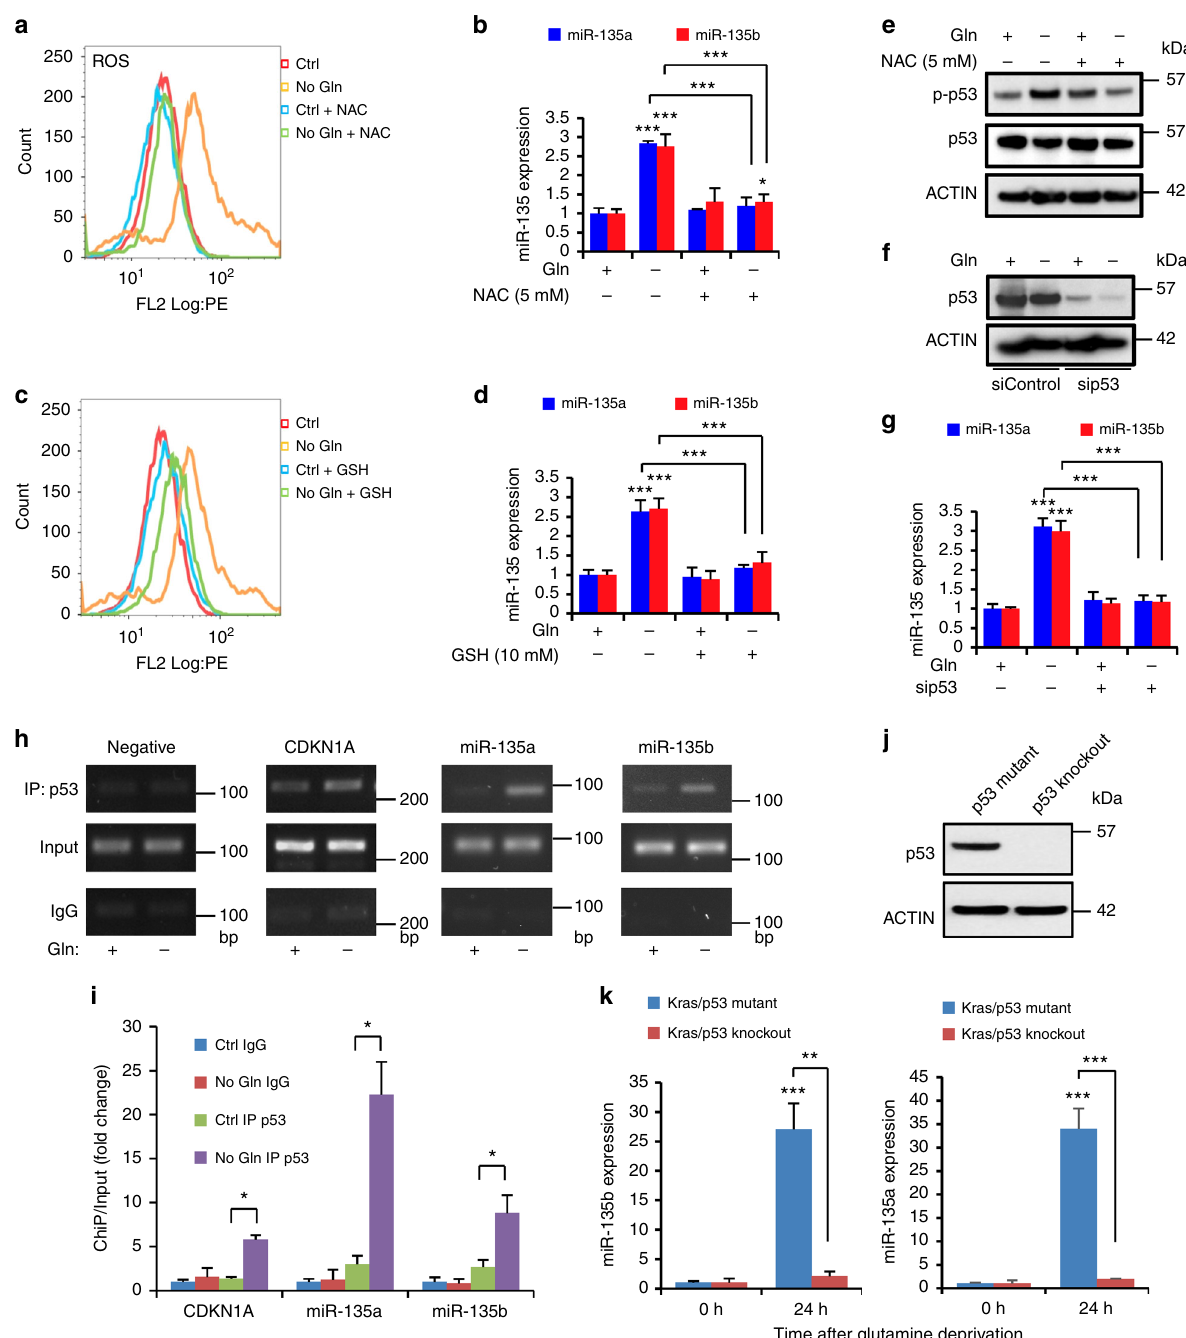
Fig. 2 miR-135 is induced by ROS-activated mutant p53. a , c MIA PaCa-2 cells were cultured in complete medium or glutamine-free medium supplemented with 5mM NAC or 10mM GSH for 24h. Then cells were stained with dihydroethidium and analyzed by fl ow cytometry or collected to assess relative miR-135a and miR-135b expression by qPCR ( b , d ). Each value represents the mean±SD in three independent experiments. * p <0.05, *** p <0.001, Student ’ s t test. e MIA PaCa-2 cells were cultured in complete medium or glutamine-free medium supplemented with 5mM NAC. Phospho-p53 (S15), total p53 and actin were assessed by western blotting. f p53 was knocked down by siRNA in MIA PaCa-2 cells. p53 protein was assessed by western blotting. g p53 knockdown and control MIA PaCa-2 cells were cultured in complete medium or glutamine-free medium for 24h. miR-135a and miR-135b expression were assessed by qPCR. Each value represents the mean±SD in fi ve independent experiments. *** p <0.001, Student ’ s t test. h Chromatin immunoprecipitation analysis was performed to determine p53 binding to the promoters of CDKN1A , miR-135a and miR-135b in response to glutamine deprivation. The binding was assessed by DNA gel. i The fold change of the p53 binding to the promoters of CDKN1A , miR-135a and miR-135b in response to glutamine deprivation were analyzed by qPCR. Each value represents the mean±SD in three independent experiments. * p <0.05, ** p <0.01, *** p <0.001, Student ’ s t test. j , k Kras/p53 mutant and Kras/p53 knockout mouse PDAC cells were cultured in complete medium or glutamine-free medium for 24h. Total p53 protein was assessed by western blotting ( j ). miR-135 expression was measured by qPCR ( k ). Each value represents the mean±SD in four independent experiments. ** p <0.01, *** p <0.001, Student ’ s t test (Ctrl: complete medium; No Gln: glutamine-free medium). ROS: reactive oxidative species, NAC: N -acetyl- L -Cysteine, GSH: glutathione, PDAC: